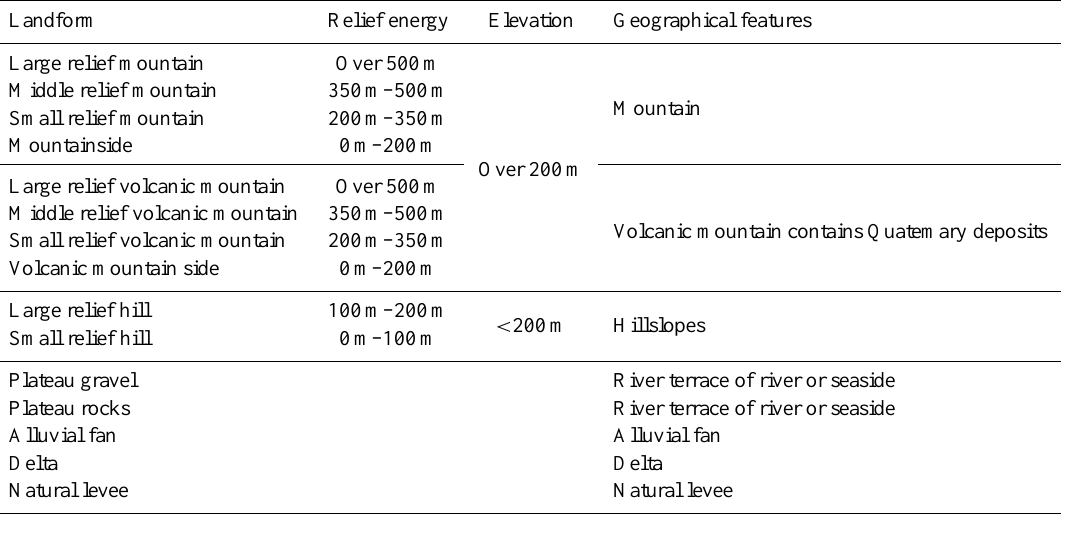
Table 5. The definitions of landform types (source: National-land information data, 2001).